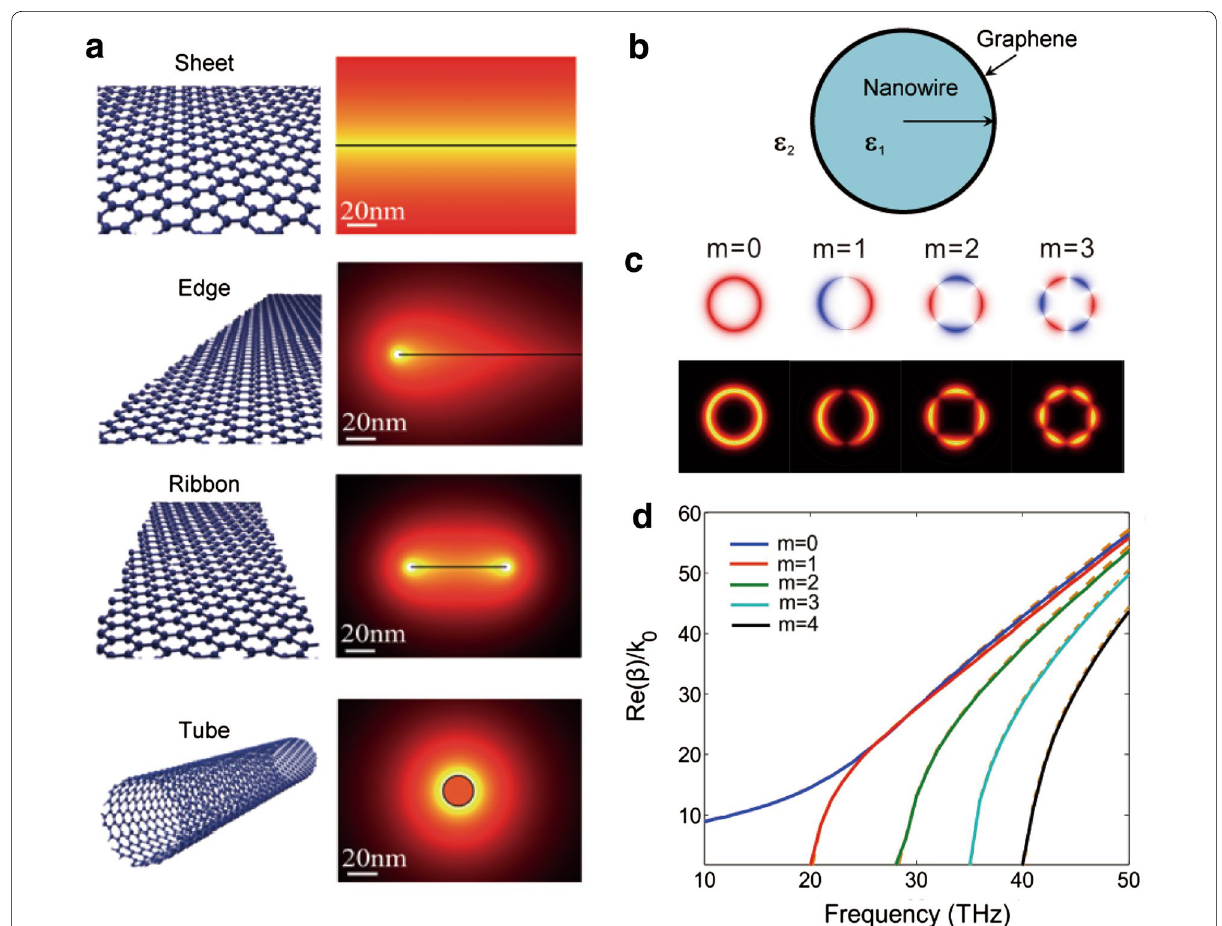
Fig. 7 Excitation and guiding of graphene plasmons in various geometrical configurations. a Plasmonic modes in different graphene structures: infinite sheet, edge, ribbon and single‑walled tube (left), and the corresponding graphene plasmon modes (right). b Schematic illustration of a graphene‑coated NW. c Electric field (top) and intensity profiles (bottom) of various graphene plasmon modes with different angular mode num‑ bers. d Dispersions of guided graphene plasmon modes with different angular mode numbers propagating along the graphene‑coated NW with a radius of 100 nm. The permittivity of the background and the NW were set to one and three, respectively, and the chemical potential of graphene was set to 0.5 eV ( a is adapted from [38] and b – d are adapted from